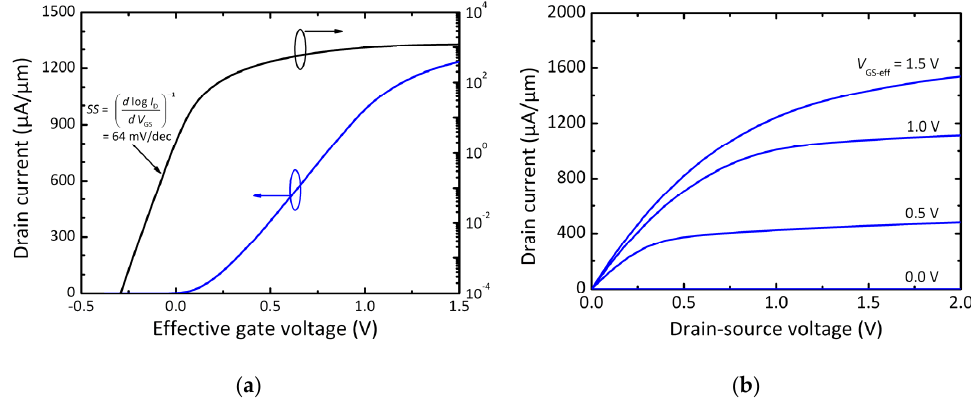
Figure 5. Steady-state characteristics of the simulated 50-nm gate single-channel GNR MOSFET: ( a ) transfer characteristics; and ( b ) output characteristics.